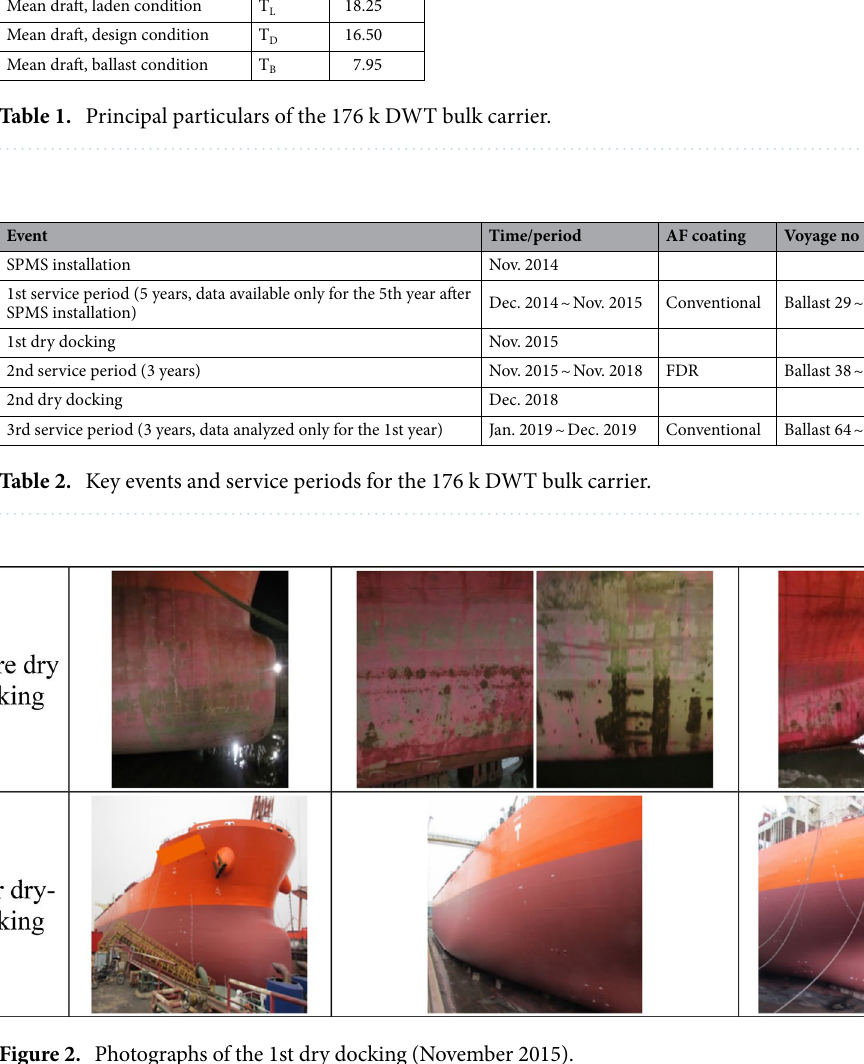
Figure 2. Photographs of the 1st dry docking (November